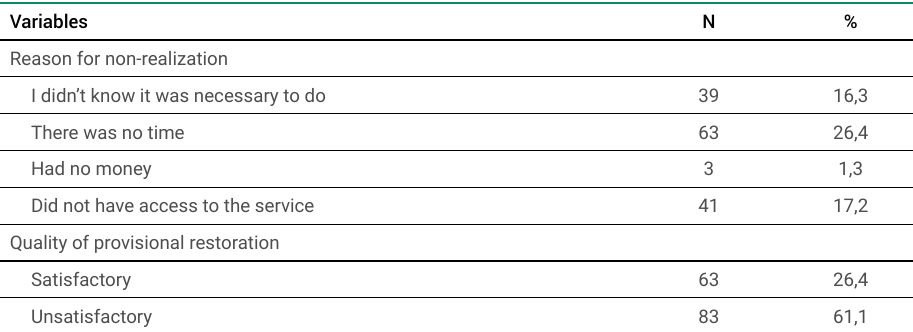
Table 2. Distribution of the frequencies of the variables of patients who did not adhere to the definitive restoration after endodontic treatment, Brazil, 2020 (n = 146). Variables N % Reason for non-realization